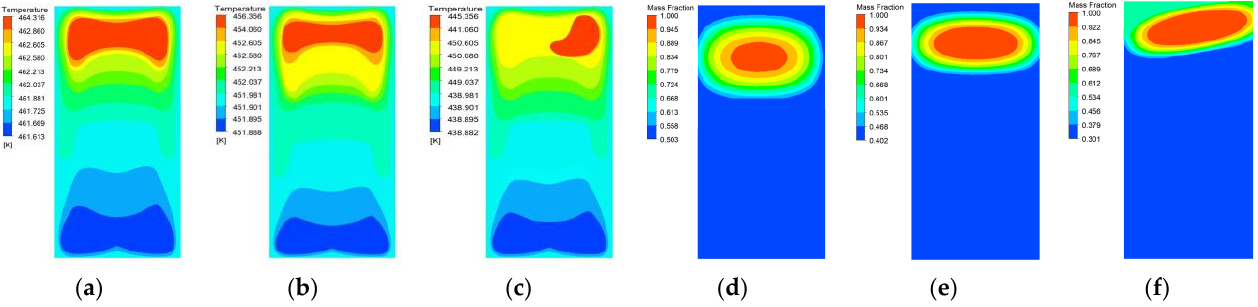
Figure 10. Temperature cloud diagram and liquid phase cloud diagram at the moment of ignition of spherical NQ/DNAN melt-cast explosives with different solid content: ( a ) 50%NQ/50%DNAN temperature distribution; ( b ) 60%NQ/40%DNAN temperature distribution; ( c ) 70%NQ/30%DNAN temperature distribution; ( d ) 50%NQ/50%DNAN liquid phase distribution; ( e ) 60%NQ/40%DNAN liquid phase distribution; ( f ) 70%NQ/30%DNAN liquid phase distribution.